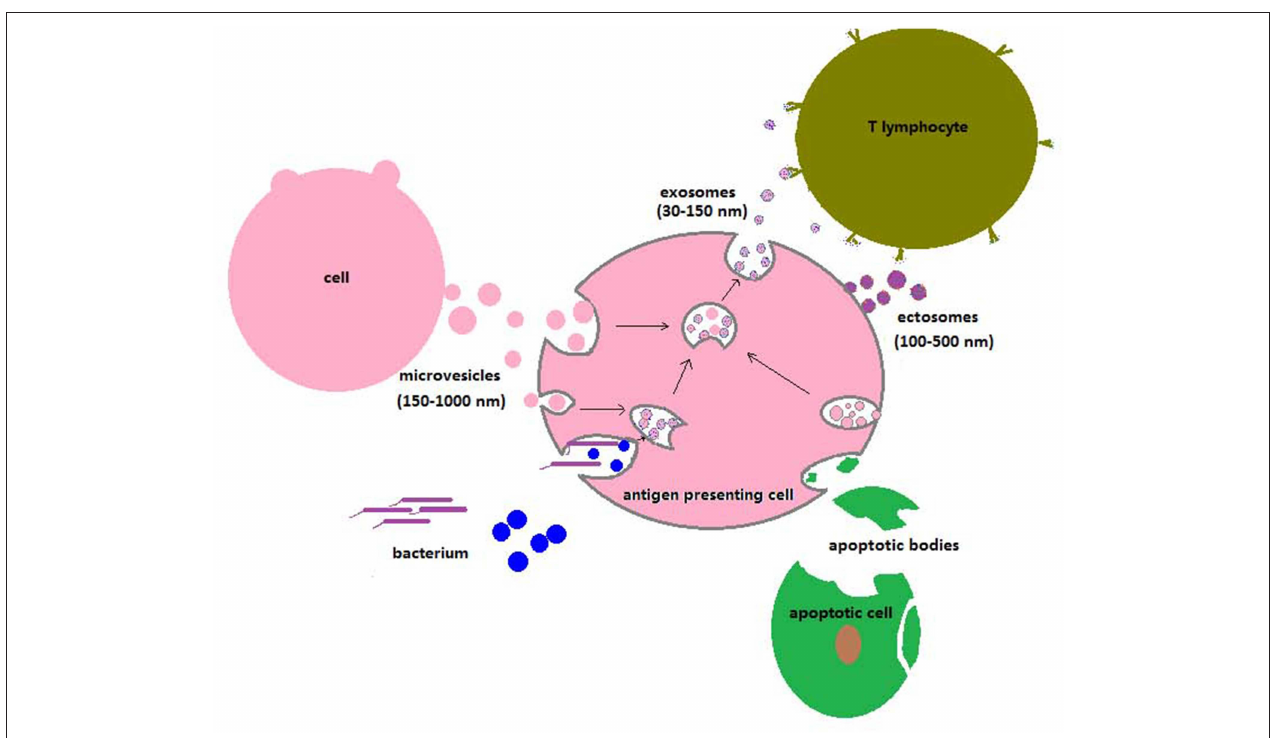
FIGURE 2 | Uptake of particles, vesicle trafficking, and release of EVs to the extracellular space by antigen-presenting cells. The extracellular particles depicted are bacteria, viruses, apoptotic bodies, ectosomes, and exosomes. Ectosomes originate from the plasma membrane, whereas exosomes have MVB origin (see section Biogenesis of the Different Extracellular Vesicle Types in the Text). Invading microorganisms, apoptotic or necrotic cells, and microvesicles of different types are phagocytosed by antigen-presenting cells. Lysosomes fuse with phagocytic vacuoles and generate phagolysosomes, where degradative reactions take place. The phagosome membrane can occasionally rupture, and microorganisms can then translocate to the cell cytosol. Exosomes or ectosomes carrying molecules of microbial origin are released and can interact with T lymphocytes to initiate specific immune responses or with uninfected antigen-presenting